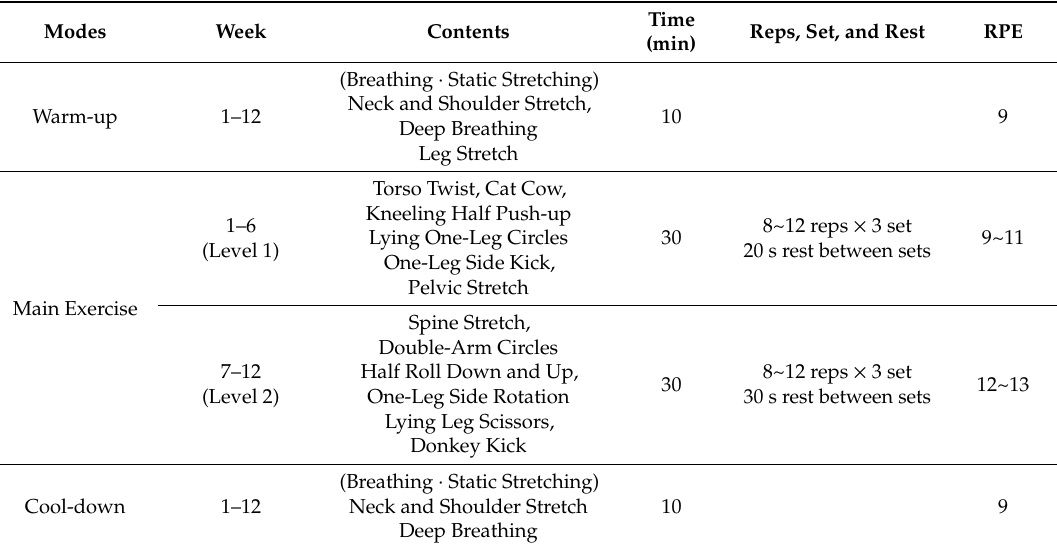
Table 1. Pilates exercise